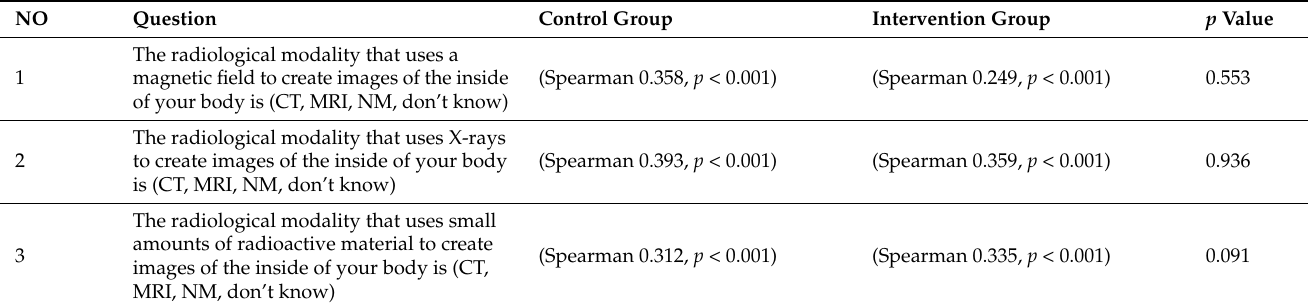
Table 1. The correlation between each question in the RLT questions and RCQ